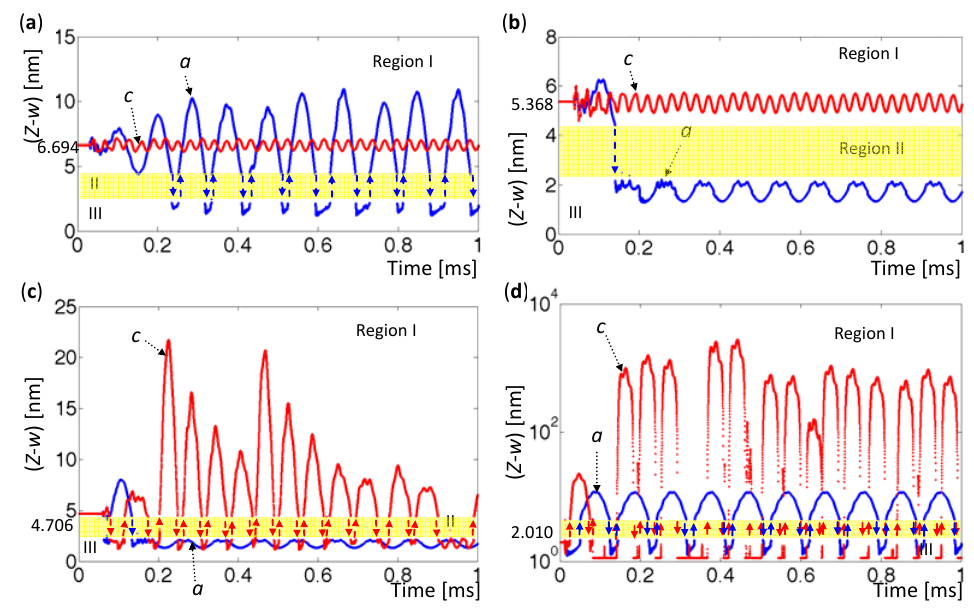
Figure 12. Time histories for various tip-sample distances. ( a ) Z − w = 6.694